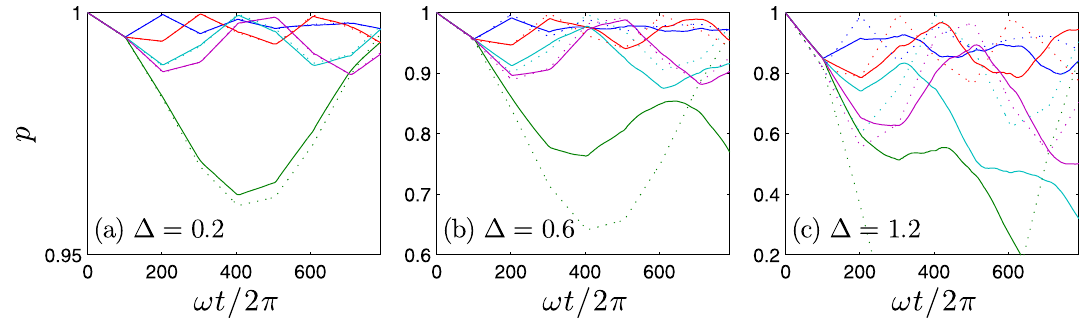
Figure 3 . (Color online) Probability of fi nding the particle in the initial Bloch state against the number of driving cycles. The lattice size is N = 601 and the period of driving is 2 π / ω = 3. The amplitude of driving is shown in each panel. In each panel, fi ve successive initial states, with 41 ≤ k i ≤ 45 are studied. The solid lines are exact results obtained by solving the time-dependent Schrödinger equation, while the dotted lines are based on (4) and (10). In each panel, at ω t /2 π = 200, from up to down, the solid lines correspond to k i = 41, 43, 44, 45, 42, respectively. The same ordering holds for the dotted lines. Note that the distance between the kinks is independent of Δ